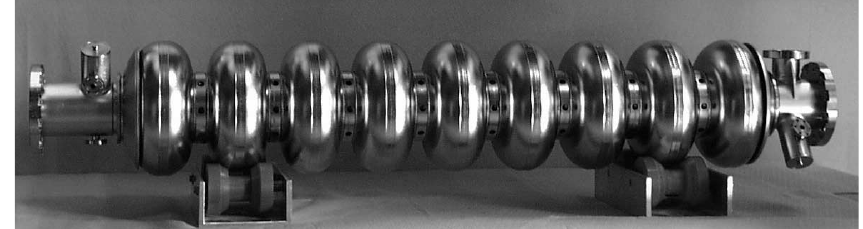
FIG. 3. Superconducting 1.3 GHz 9-cell cavity for the TESLA Test